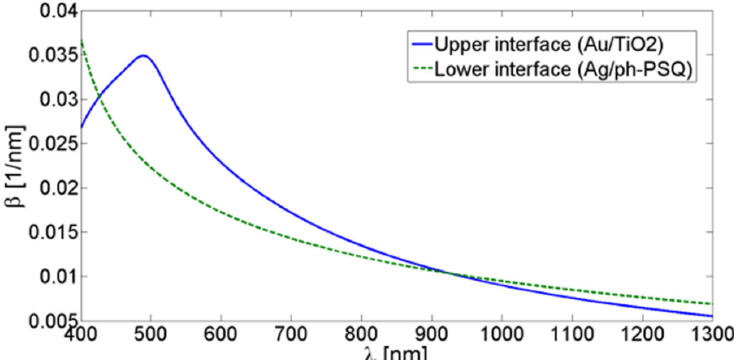
Figure 3. Estimated momenta of the surface plasmon polaritons (SPPs) at the front and back interfaces, as a function of the incident wavelength in the range of interest.